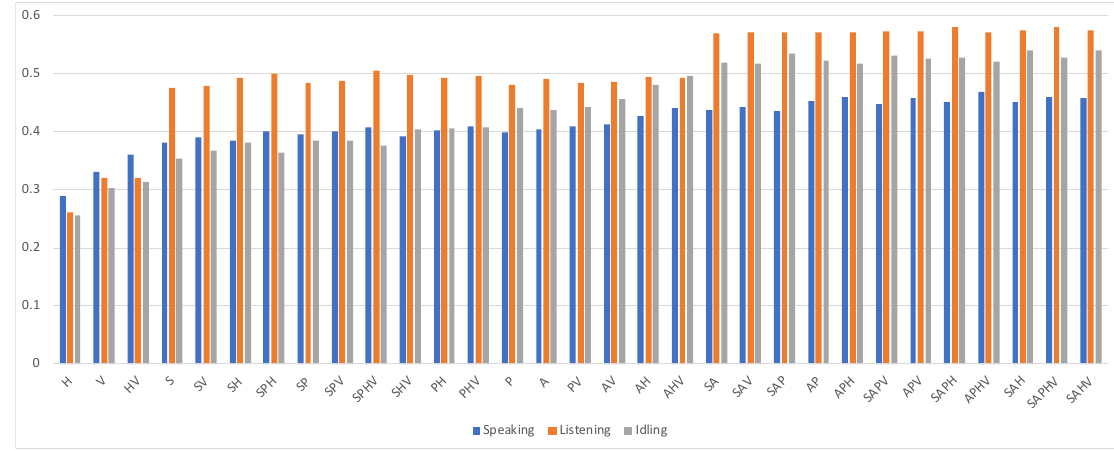
Figure 6. F-measure values (vertical axis) showing the performance of the attention focus prediction models in speaking, listening, and idling situations with all 31 combinations of feature sets: the bars are sorted in the order of the performances of listening